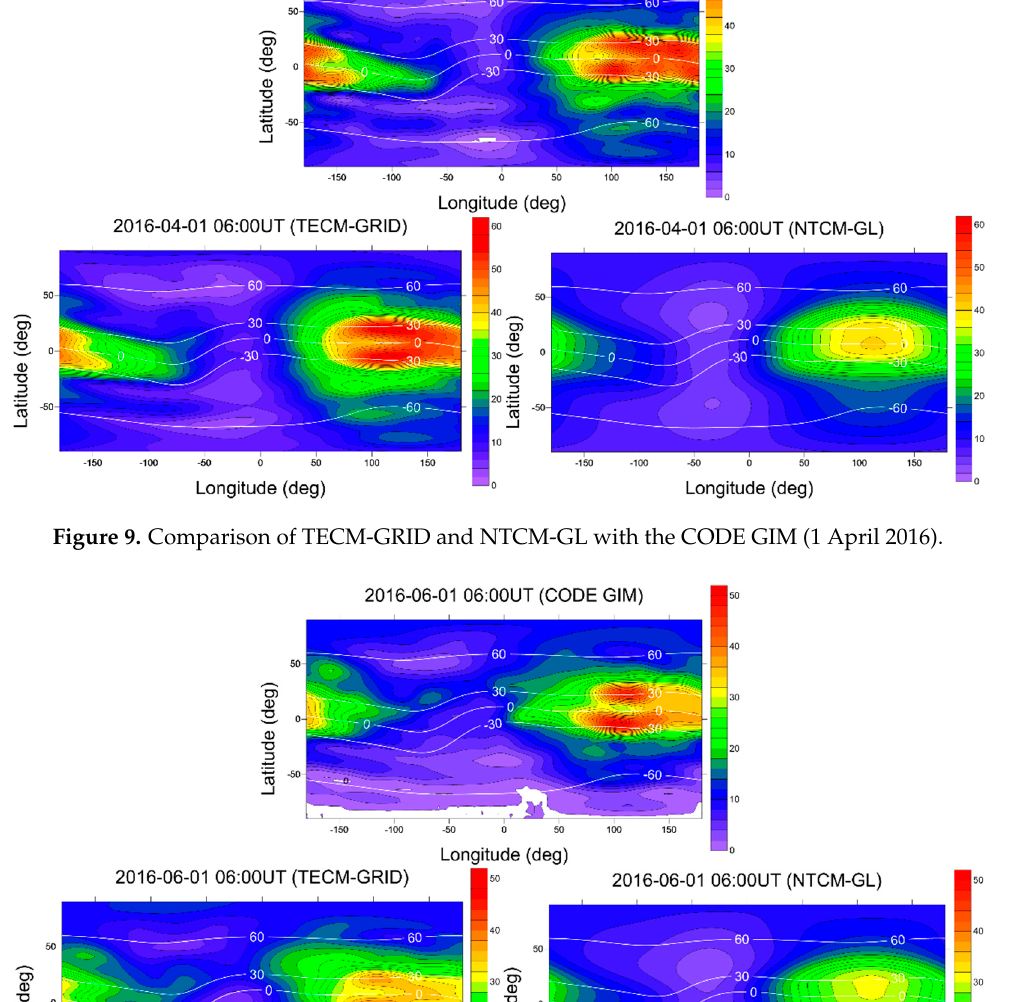
Figure 8. Comparison of TECM-GRID and NTCM-GL with the CODE GIM (1 February 2016).